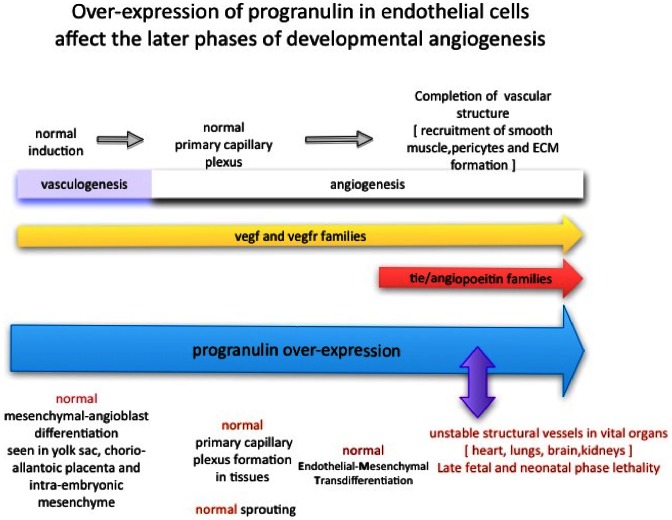
Summary of the effect of expression of progranulin during vascular development.The upper bar summarizes major landmarks in vascular development. VEGF and its receptors (yellow bar) are required for early vasculogenesis and for angiogenesis throughout development. Tie2 and its ligand angiopoietin (red bar) are required for cardiac development and for vessel stabilization, but not for early vasculogenesis (see text for details). When progranulin was expressed developmentally (purple bar) it had no effect on vasculogenesis, the formation of the primary capillary plexus, sprouting or endothelial-mesenchymal transition. Its major actions were on vessel size and structural stability in late embryonic and neonatal phases. The timing of its actions is therefore distinct from those of the well-established angiogenic growth factors, suggesting that its effect on vessel growth and stability constitutes a novel angiogenic pathway.